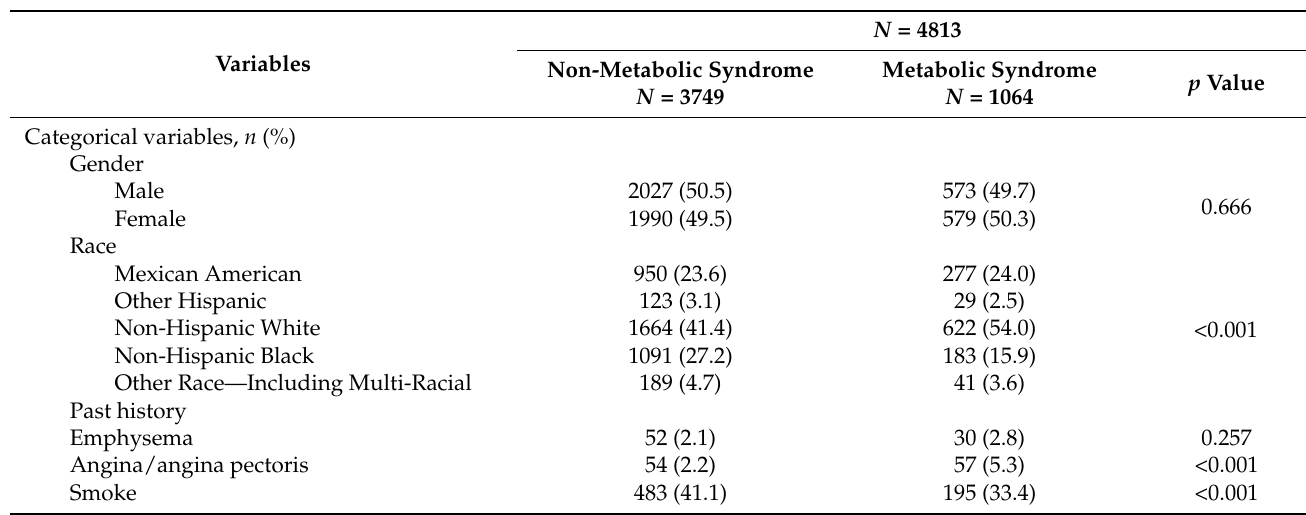
syndrome markers. In the adjusted model, log-transformed HbAA concentration inversely correlated with the number of metabolic syndrome markers (3: β coefficient = − 0.051; 95% confidence intervals (CI) = − 0.141, − 0.040; p = 0.275 and 4–5: β coefficient = − 0.127; 95% CI = − 0.229, − 0.025; p = 0.015). Most results for correlation with log-transformed HbGA were not significant in the adjusted model, except for high glucose level ( β coefficient = − 0.072; 95% CI = − 0.135, − 0.008; p = 0.027). Increased concentrations of HbAA were noted with high triglycerides and low HDL cholesterol in the adjusted model ( p < 0.05) (Figure 1). High blood pressure negatively correlated with the concentration of HbAA in Model 1 but was insignificant after multivariate model adjustment (Model 2). In Table 4, the presence of metabolic syndrome was statistically significantly associated with concentrations of HbAA based on quartile analysis in Model 2 (Q2 vs. Q1: OR = 0.604; 95% CI = 0.424, 0.860; Q3 vs. Q1: OR = 0.579; 95% CI = 0.410, 0.817; Q4 vs. Q1: OR = 0.595; 95% CI = 0.404, 0.876; all p < 0.05). The association between concentrations of HbGA and metabolic syndrome was